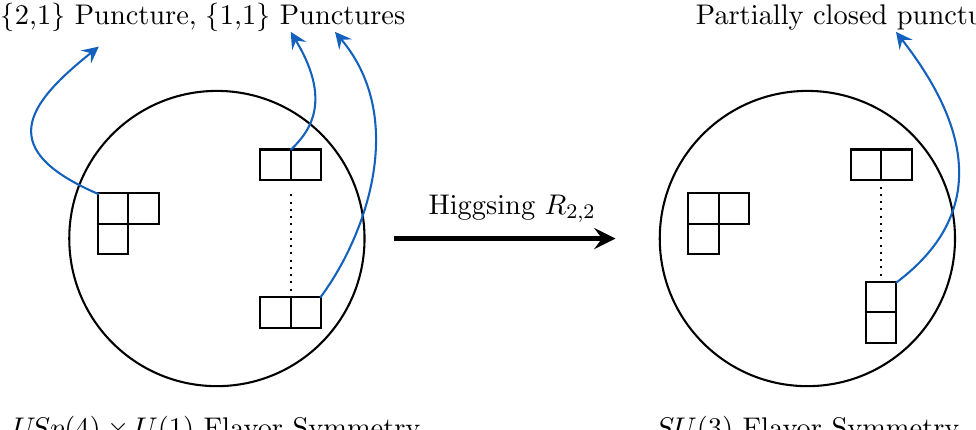
Figure 24. The class S description of Higgsing R 2 , 2 to the ( A 1 , D 4 ) Argyres-Douglas theory. SU(2) symmetry enhancing to USp(4) is associated with the twisted punctures, and U(1) is associated with the untwisted puncture. It was argued in [78] that partially closing one of the twisted punctures, as in the right hand side of figure 24, we get the ( A Argyres-Douglas theory and one decoupled